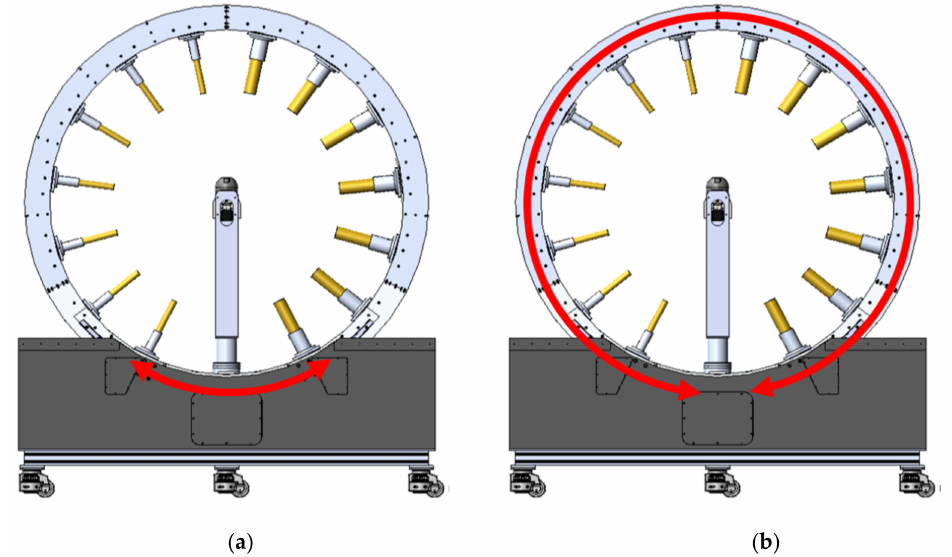
Figure 2. Multi-probe driving method. ( a ) Goniometer; ( b ) Probe array